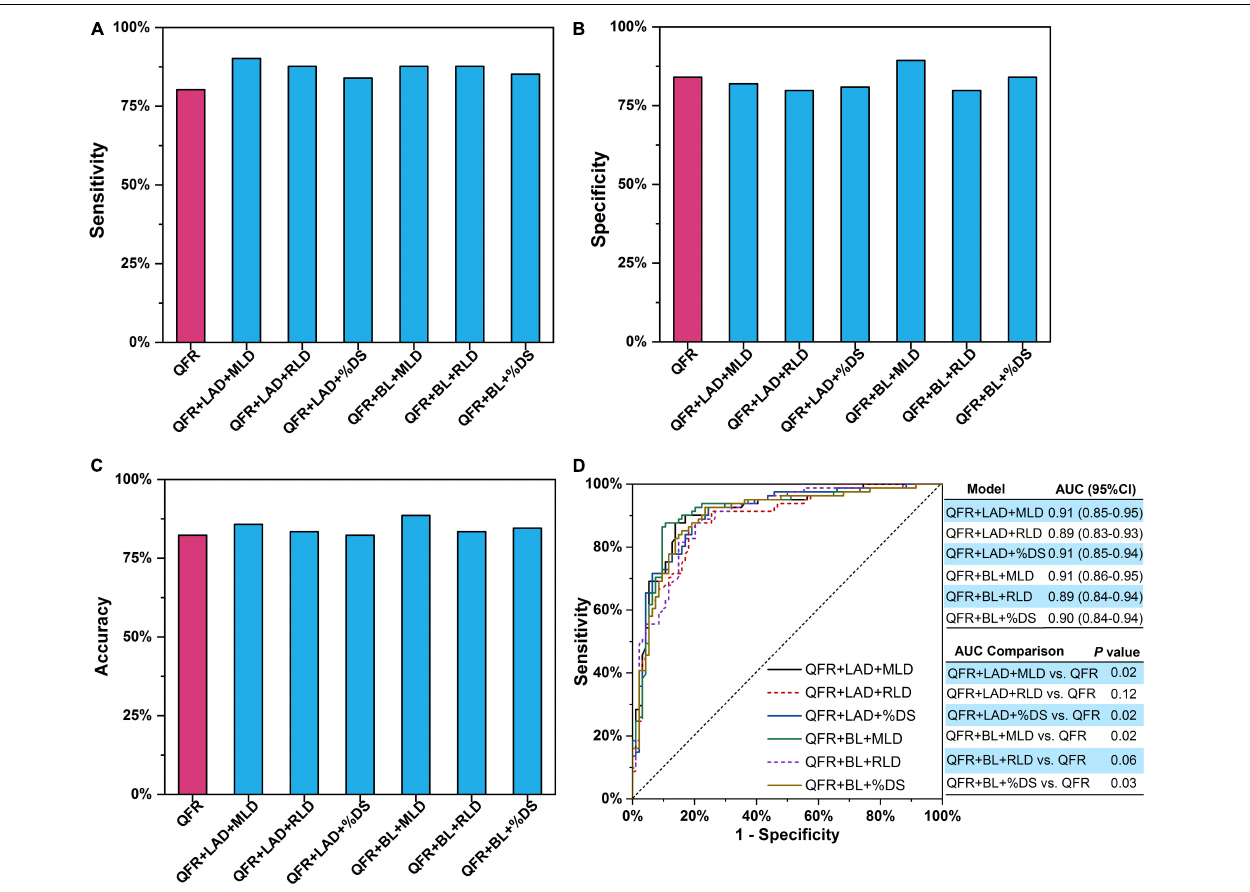
FIGURE 5 | Two lesion parameters combined with QFR for predicting myocardial ischemia. (A) Sensitivity. (B) Specificity. (C) Accuracy. (D) AUCs. The P -value reflects the AUC comparison between the combined model and QFR. QFR, quantitative flow ratio; LAD, left anterior descending artery; MLD, minimal lumen diameter; RLD, reference lumen diameter; %DS, percent diameter stenosis; BL, side branch at lesion site; ML, multiple lesions with %DS > 30%; AUC, area under receiver operator characteristic curve; CI, confidence interval.